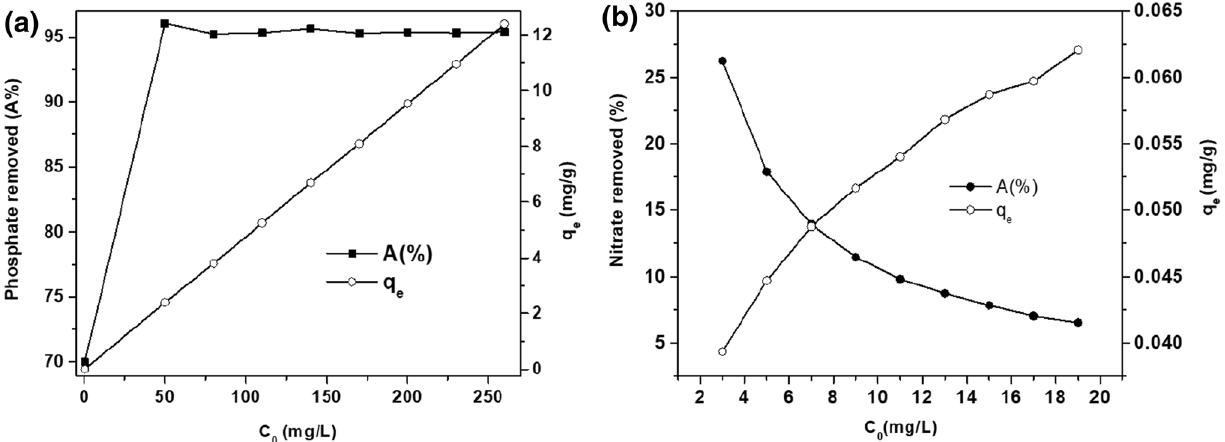
Fig. 4 Effect of initial concentration on the simultaneous removal of a phosphate and b